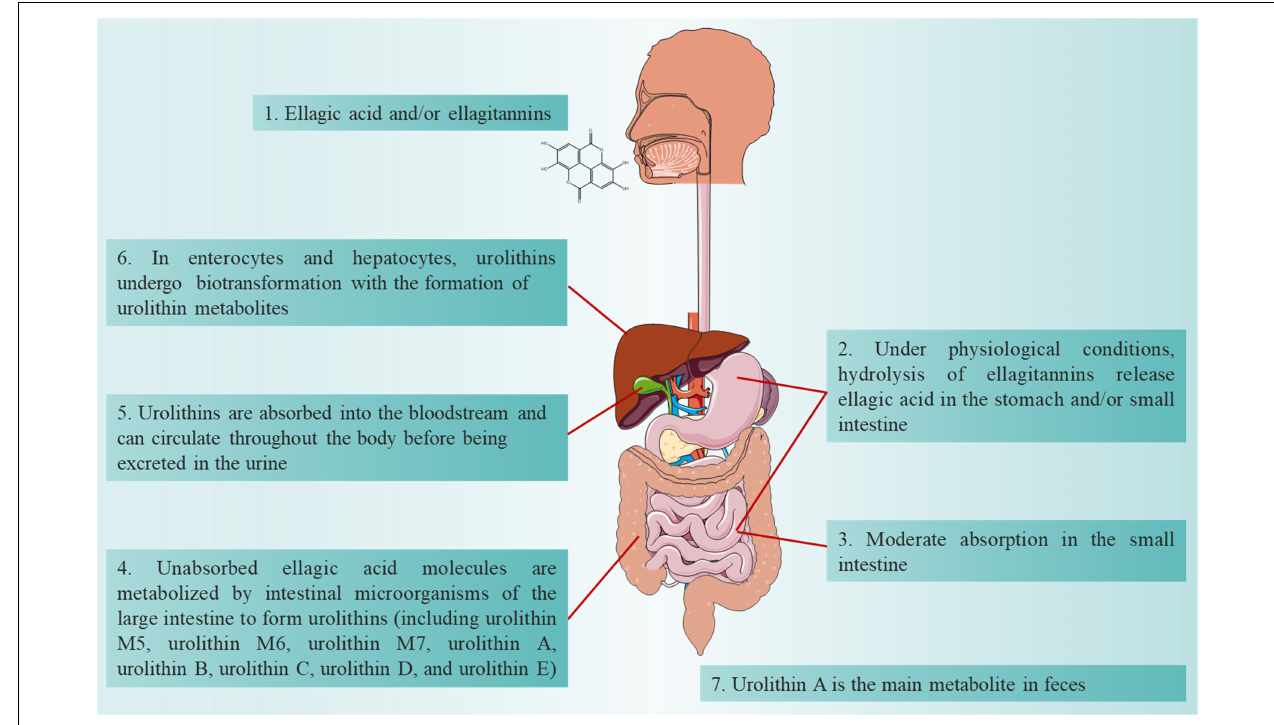
FIGURE 2 | Absorption, distribution, metabolism and excretion processes of ellagic acid (EA) in the body.